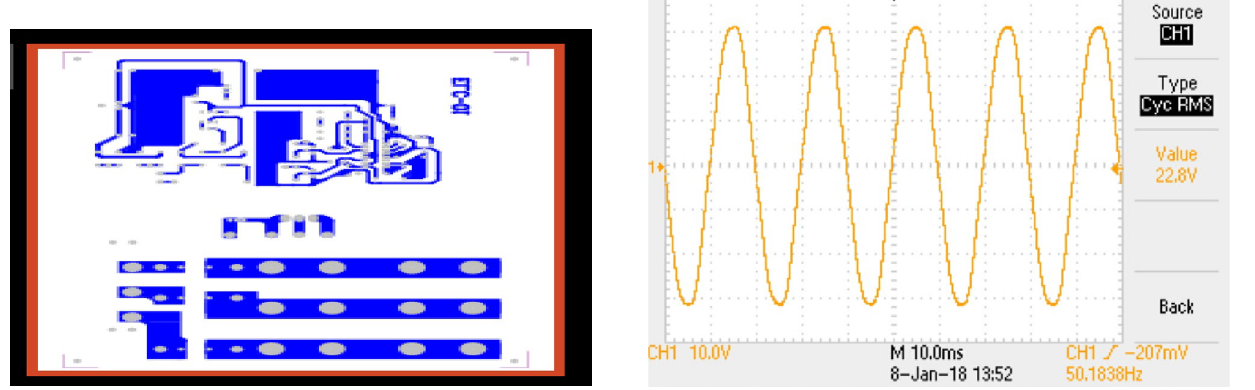
Fig. 7 Single-phase voltage (228 V) fed to